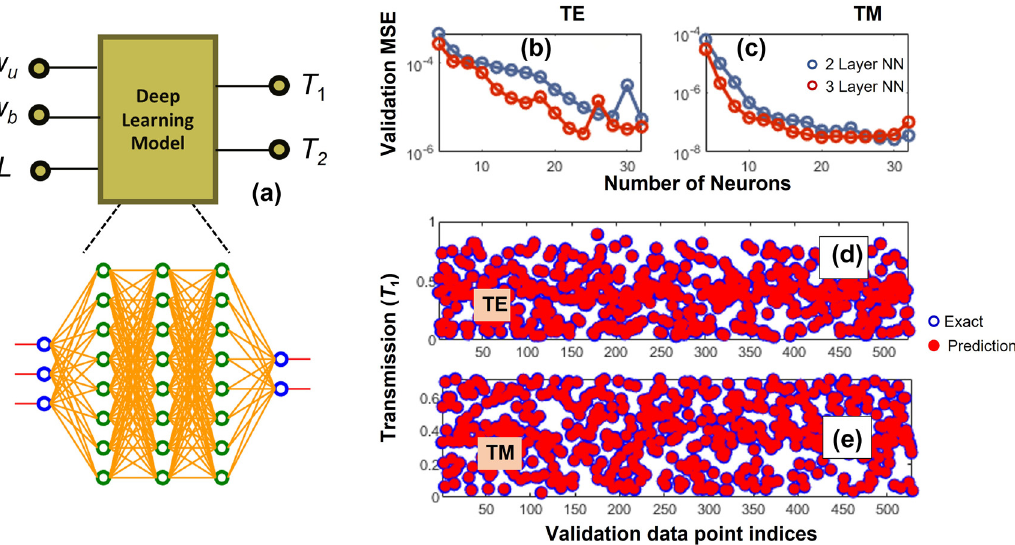
Figure 3: Deep learning based forward model. (a) The deep learning architecture with full feedforward connections. The validation mean-squared error (MSE) for (b) TE-polarization, and (c) TM-polarization. Transmission of the upper output waveguide for various geometries in the validation data set for (d) TE-polarization, and (e) TM-polarization. In (d) and (e), blue – exact values obtained from 3D FDTD; red – deep learning